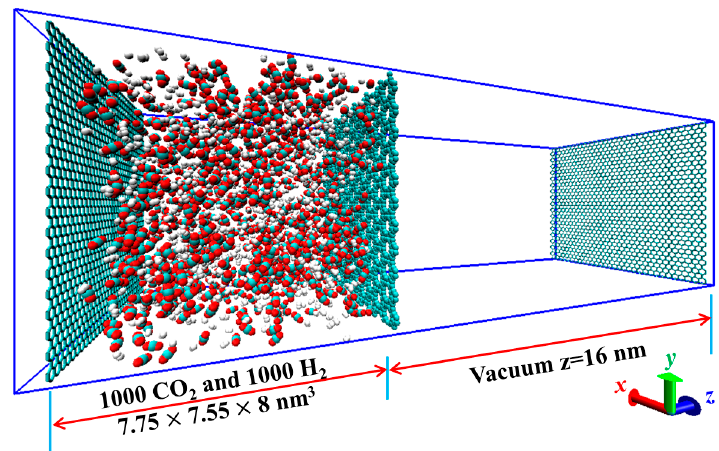
Figure 2. Simulation system of the equimolar binary mixture of H 2 /CO 2 permeating through the GDY_2.1Å membrane. Atom: C (Cyan); O (red); H (white).